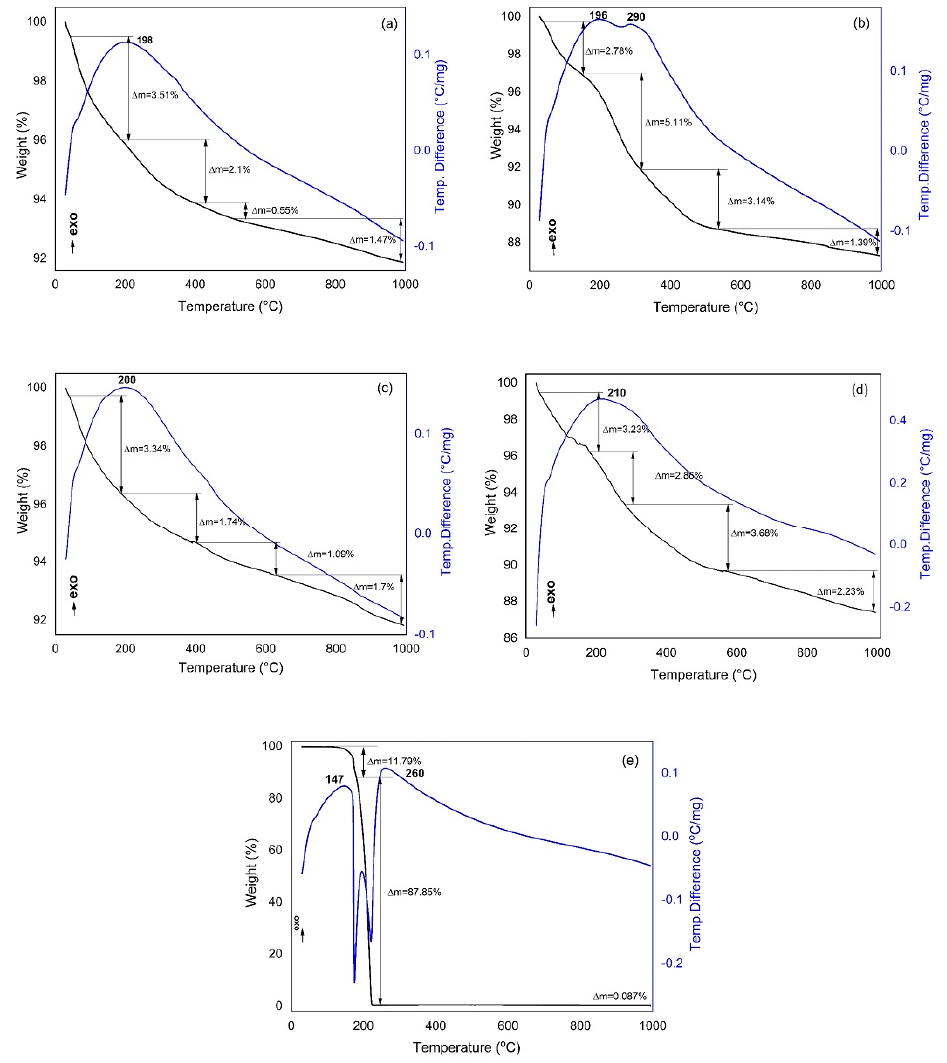
Figure 2. TG (black)/DTA (blue) plot of ( a ) HAP, ( b ) HAP_4AP_25, ( c ) Si − HAP, ( d ) Si − HAP_4AP_25 and ( e ) 4AP, respectively.